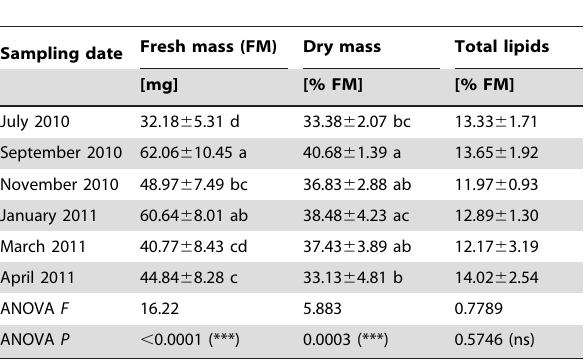
Table 1. Seasonal changes in fresh mass, dry mass and total lipids in field-collected caterpillars of Cydia pomonella